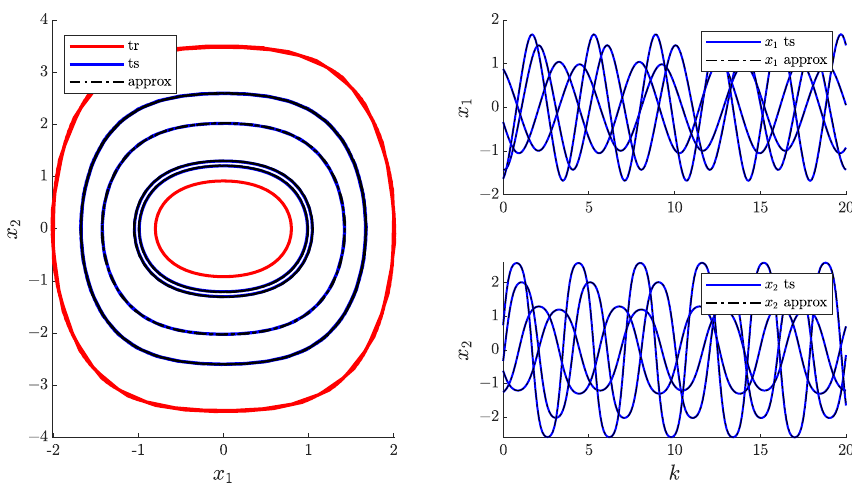
Figure 4. pqEDMD approximation for the undamped Duffing